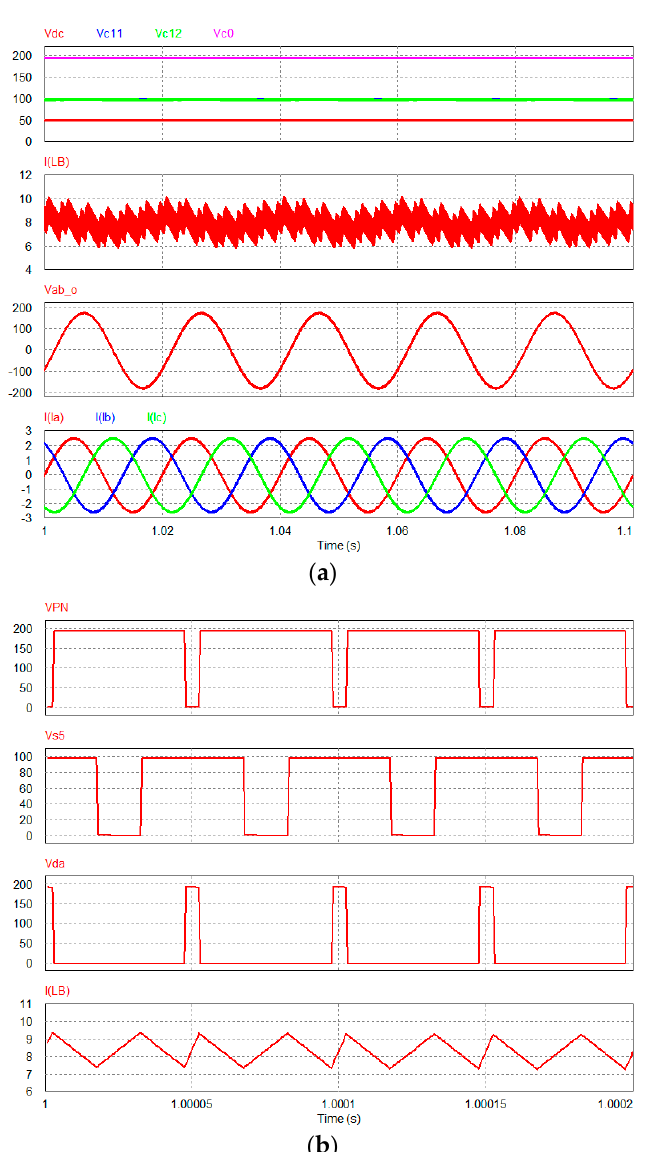
Figure 8. Simulation results for the proposed three-phase VMC-qSBI when V dc = 50 V, D ST = 0.1, D 5 = 0.3, and M = 0.9 × 1.15. From top to bottom: ( a ) input voltage and capacitors voltages, input